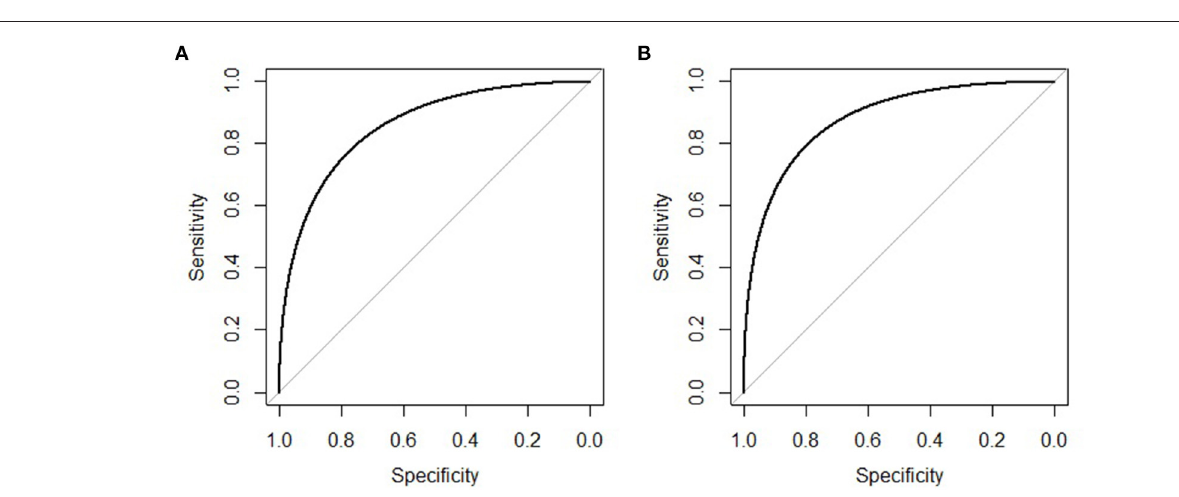
FIGURE 5 | ROC curve of the nomogram in the training and validation cohort. (A) ROC curve of the nomogram in the training cohort. (B) ROC curve of the nomogram in the validation